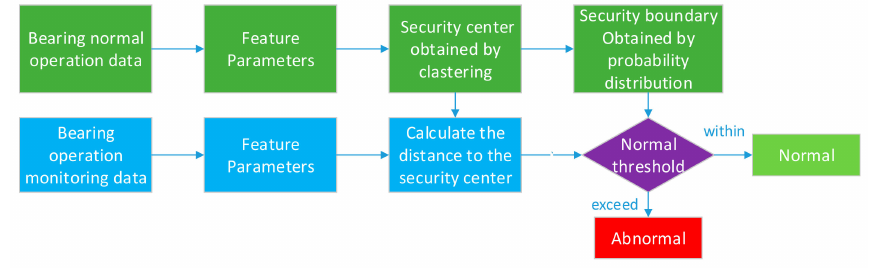
Figure 1. The block diagram of the proposed method.